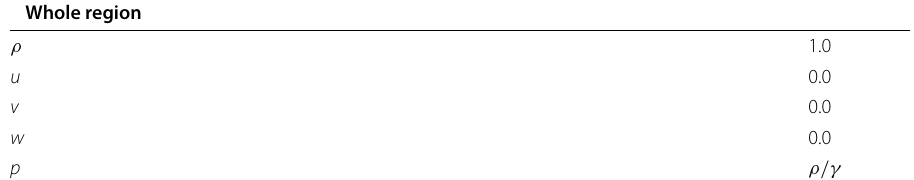
Table 2 Initial conditions (crossing test) Whole